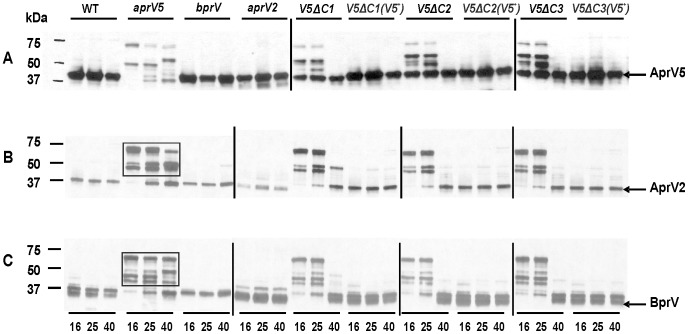
Western immunoblotting of wild-type and mutants with specific protease antisera.Concentrated culture supernatants (3 µg) from 16 h, 25 h and 40 h (from left to right ) TAS growth of the wild type strain VCS1703A (WT), the aprV5Δ478–595 strain JIR3947 (V5ΔC1), the aprV5Δ503–595 strain JIR3956 (V5ΔC2), the aprV5Δ560–595 strain JIR3969 (V5ΔC3) and their complemented derivatives of JIR3968 (V5ΔC1(V5+), JIR3965 (V5ΔC2(V5+) and JIR3978 (V5ΔC3(V5+) were separated on 4–15% gradient SDS-PAGE and analysed by Western immunoblotting with (A) AprV5 (1∶4000)-, (B) AprV2 (1∶300)- and (C) BprV (1∶4000)- antisera. The aprV5 mutant JIR3756 (aprV5), the aprV2 mutant JIR3743 (aprV2) and the bprV mutant JIR3928 (bprV) were included as controls. The two groups of larger proteins in the aprV5 preparation are boxed.